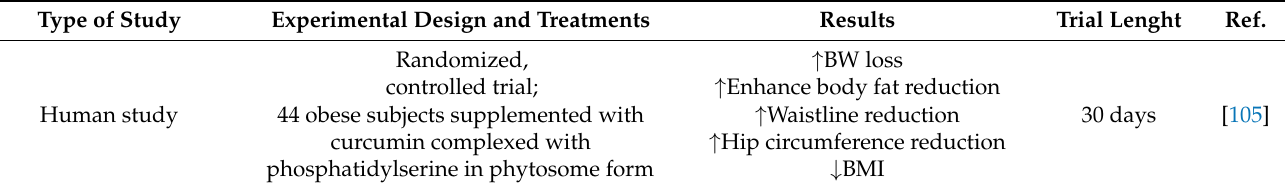
Table 1. Effect of curcumin on obesity in human, animal and in vitro studies. An explanation of the abbreviations can be found at the end of the